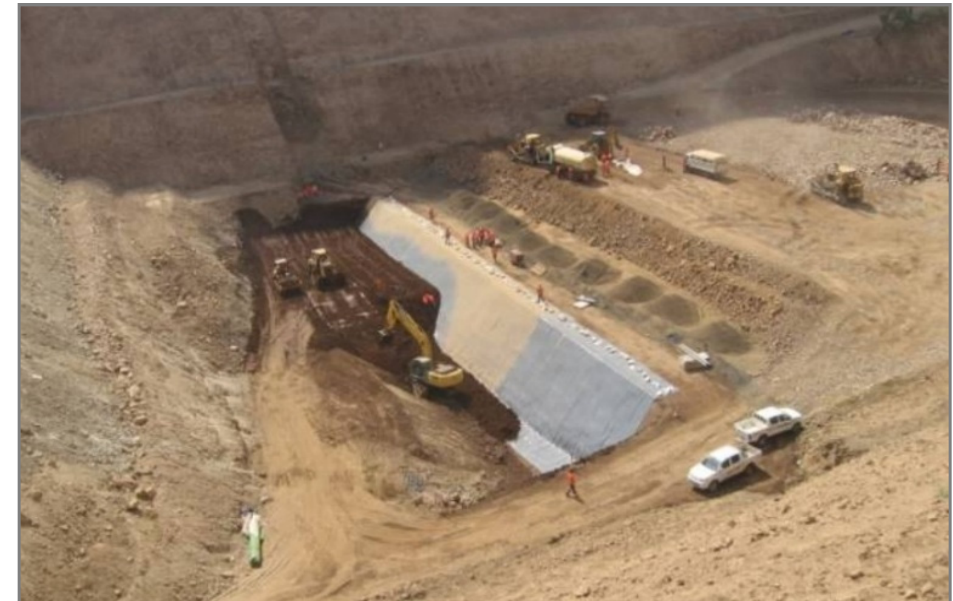
Figure 7. Example of cutoff trench and grout curtain system construction in a TSF.